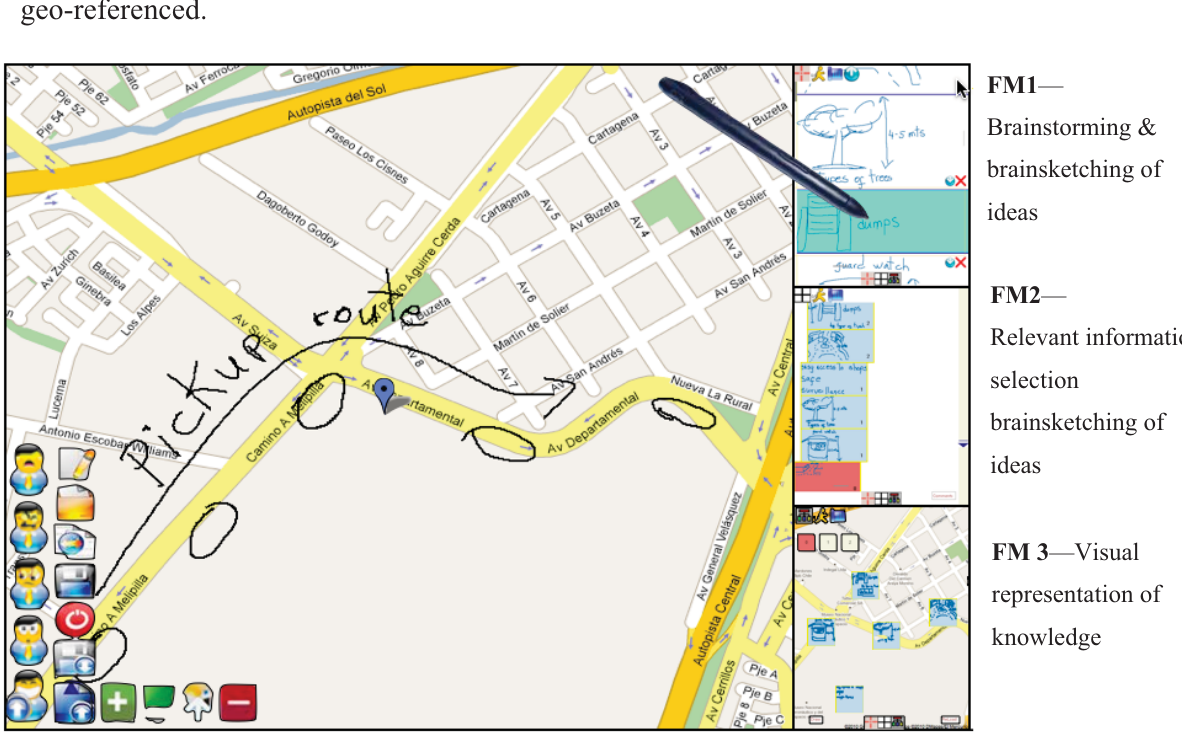
Figure 2. Main human computer interface of the application. The FM1 , FM2 , and FM3 modes are at the right column. The figure shows the case of how an idea corresponding to the design of a dump edited in the mode brainstroming & brainsketching and selected by the Tablet-PC pen has been associated to sketches specified on the map, indicating where the dumps should be located. In the mode of relevant information a list of many ranked ideas can be seen. In the mode of Visual representation of knowledge creation it can be seen the ideas selected and associated to the map where the place they should be applied is